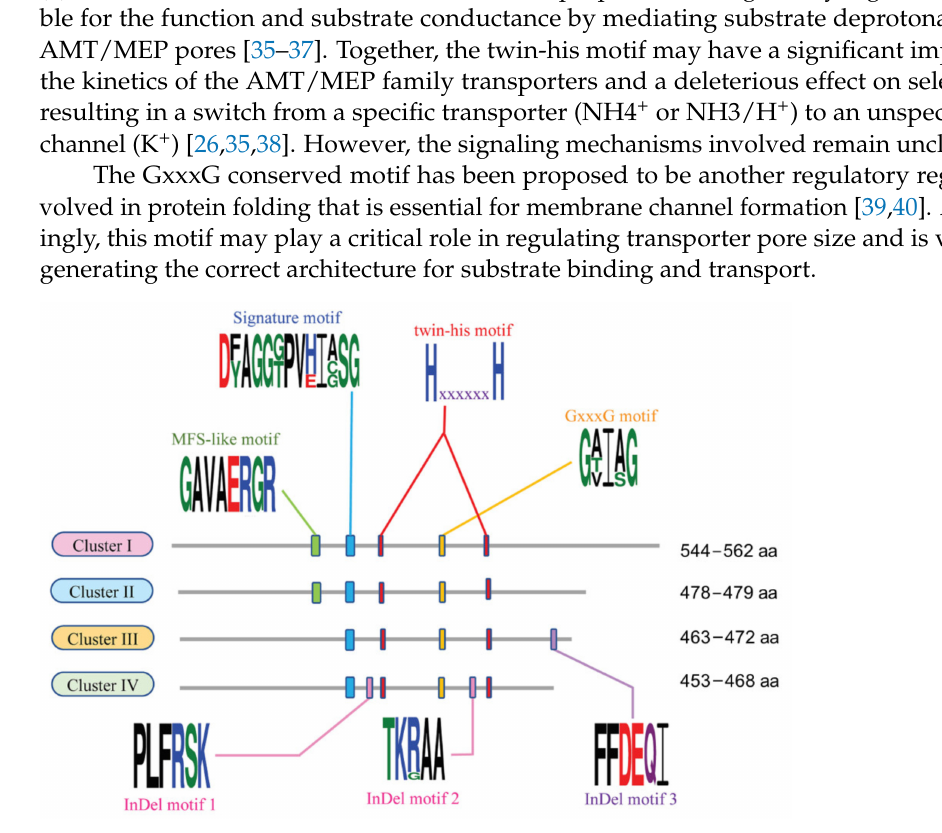
Figure 3. Distribution of consensus motifs in four clusters of Aspergillus ammonium transporters. The sequence logo was generated by WebLogo 3 (http://weblogo.threeplusone.com/, accessed on 11 March 2022) [41], showing signature features, including twin-his, GxxxG, MFS-like, and InDel motifs as indicated by blue, red, yellow, green, and pink boxes, respectively. The height of each letter is proportional to its frequency of occurrence. Hydrophobic residues are indicated by black letters. Acidic and basic amino acids are represented by red and blue letters, respectively. Polar and neutral residues are depicted by green and purple letters, respectively. “x” in the twin-his motif is defined as a non-specific amino acid residue. The number of amino acids (aa) in each cluster is